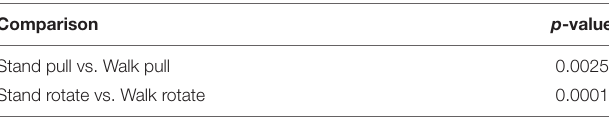
TABLE 3 | Comparison of the sample entropy of EEG signals between walking and standing in case of pulling and rotating. Comparison p -value Stand pull vs. Walk pull Stand rotate vs. Walk rotate